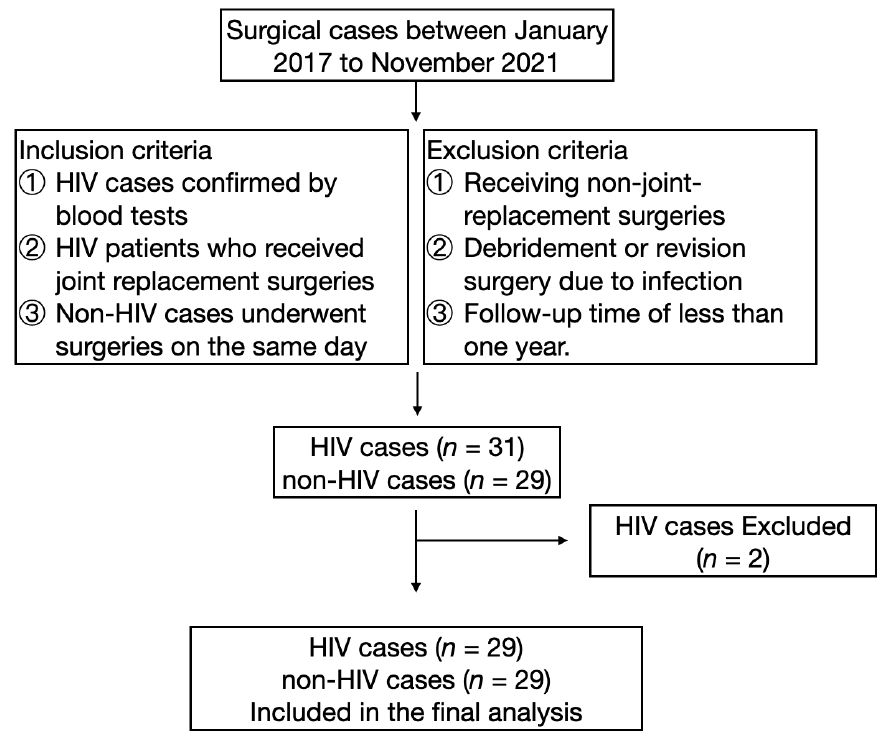
Figure 1. Flowchart of included and excluded patients. On the same day, 29 non-HIV patients underwent joint replacement surgery. There were 12 men and 17 women, with a mean age of 65.6 ± 9.6 years and a mean BMI of 24.5 ± 3.3. Patients were comorbid with hypertension ( n = 12), diabetes mellitus ( n = 5), and other medical diseases. In total, 16 patients underwent THA, with no patients receiving bilateral THA. There were 10 knee OAs managed with TKA and 3 knee OAs receiving UKA. The comparison of the relevant indicators between the two groups is shown in Table